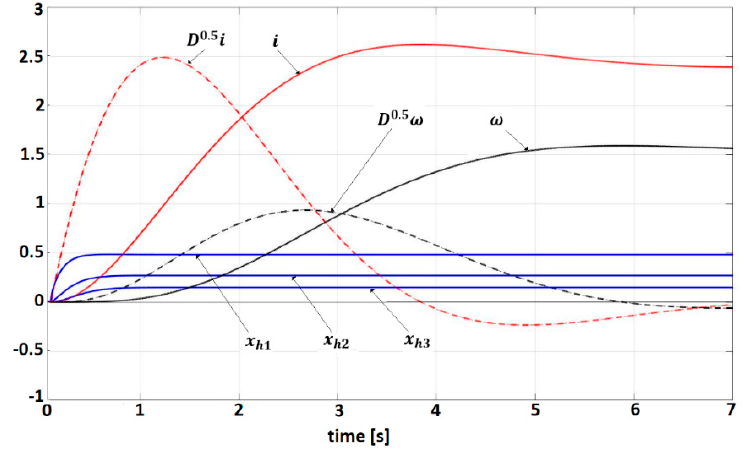
Figure 8. Man-wheelchair system trajectories.